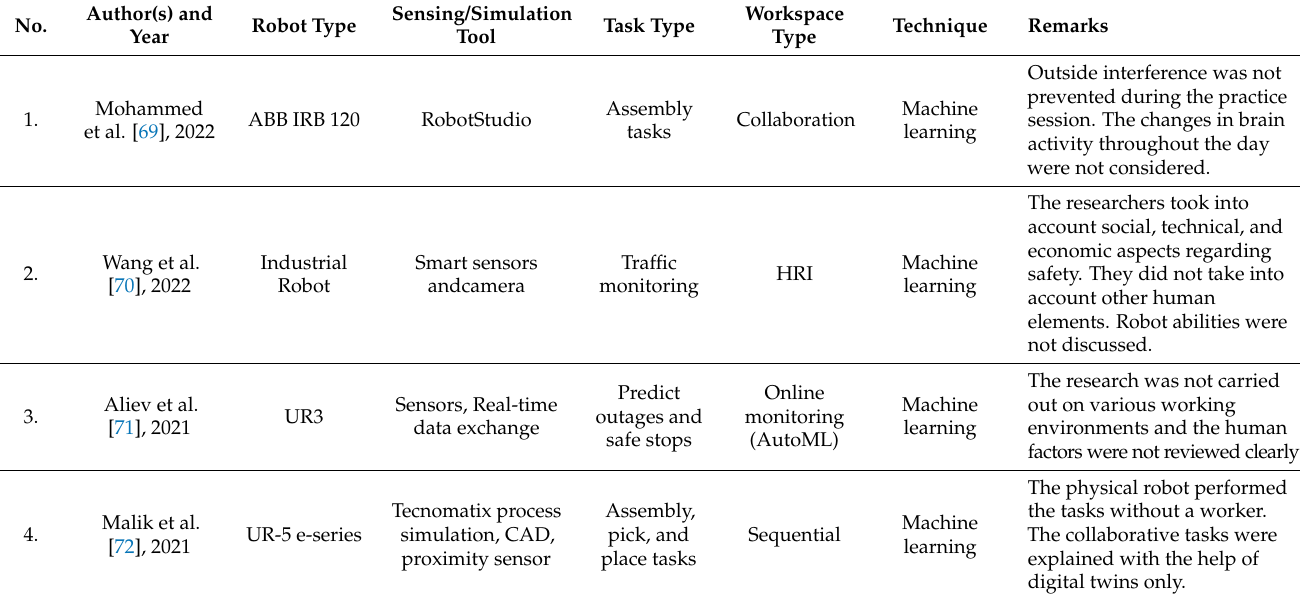
Table 4. Summary of the state-of-art research on industrial robots employing machine